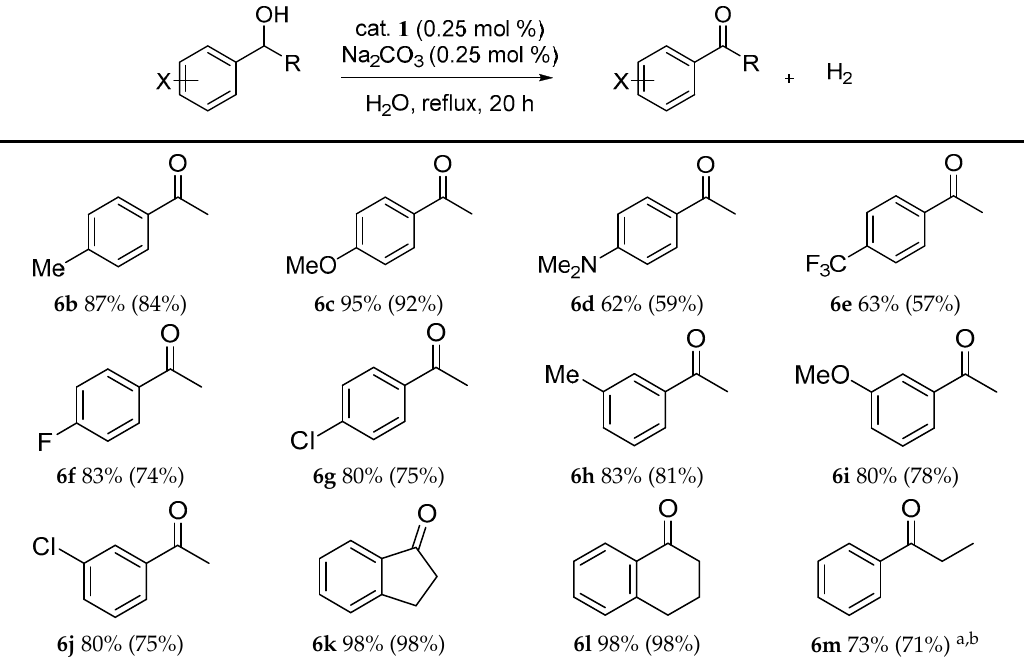
Table 3. Dehydrogenative oxidation of various secondary alcohols to the corresponding ketones catalyzed by 1 in aqueous media.